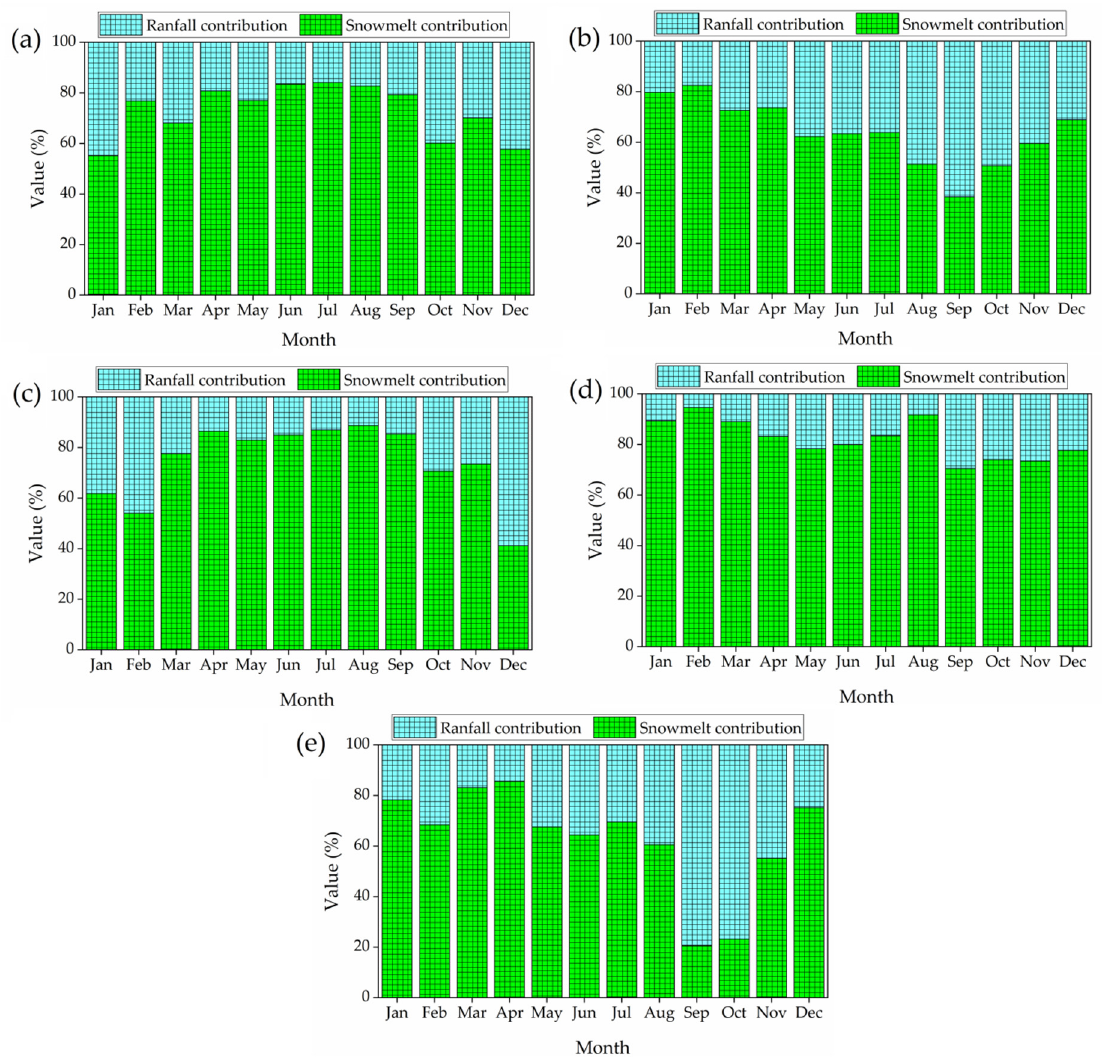
Figure 9. Mean monthly rainfall and snowmelt contribution in the Upper Vakhsh River flow, using the SWAT model with ( a ) APHRODITE_V1101+CFSR, ( b ) APHRODITE_V1101+CRU TS3.1, ( c ) CFSR, ( d ) CRU TS3.1, and ( e ) observational datasets.